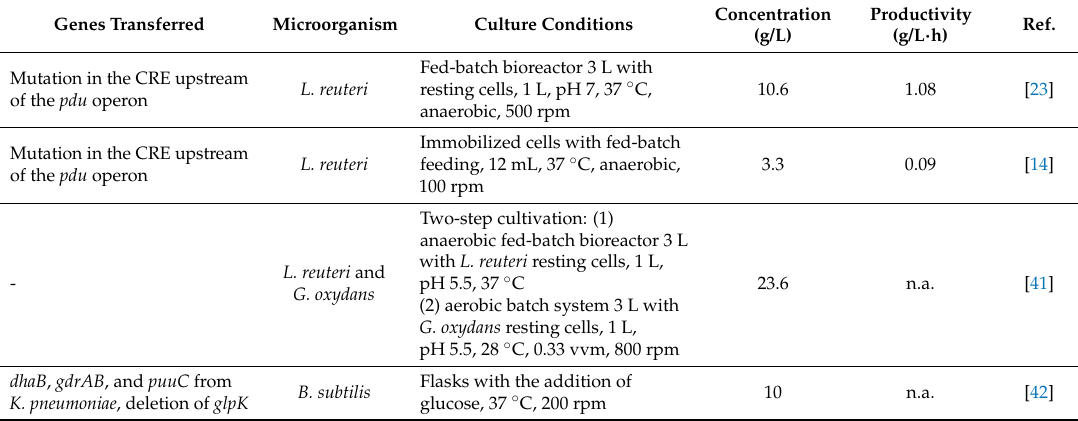
Table 3. Results of 3HP production from glycerol using other host